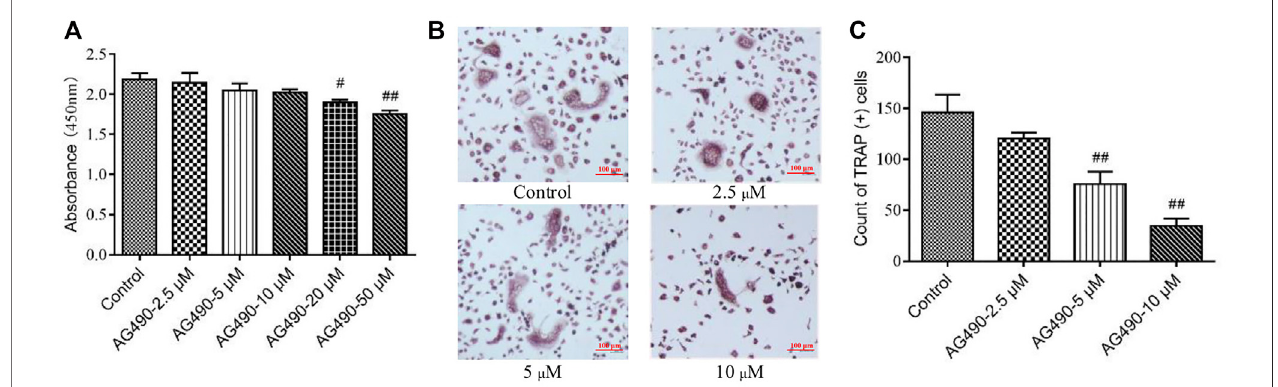
FIGURE 1 | Effect of AG490 on cells viability and osteoclastogenesis in the OC single culture system. (A) Cells (OPCs and OCs) viability was assessed by CCK-8 assays after treatment with AG490 (0, 2.5, 5, 10, 20, or 50 μ M). (B,C) TRAP staining in OCs after treatment with AG490 (0, 2.5, 5 or 10 μ M). Scale bars (cid:2) 100 µm. The data are shown as the mean ± SEM (n ≥ 2). # p < 0.05, ## p < 0.01 compared with the control